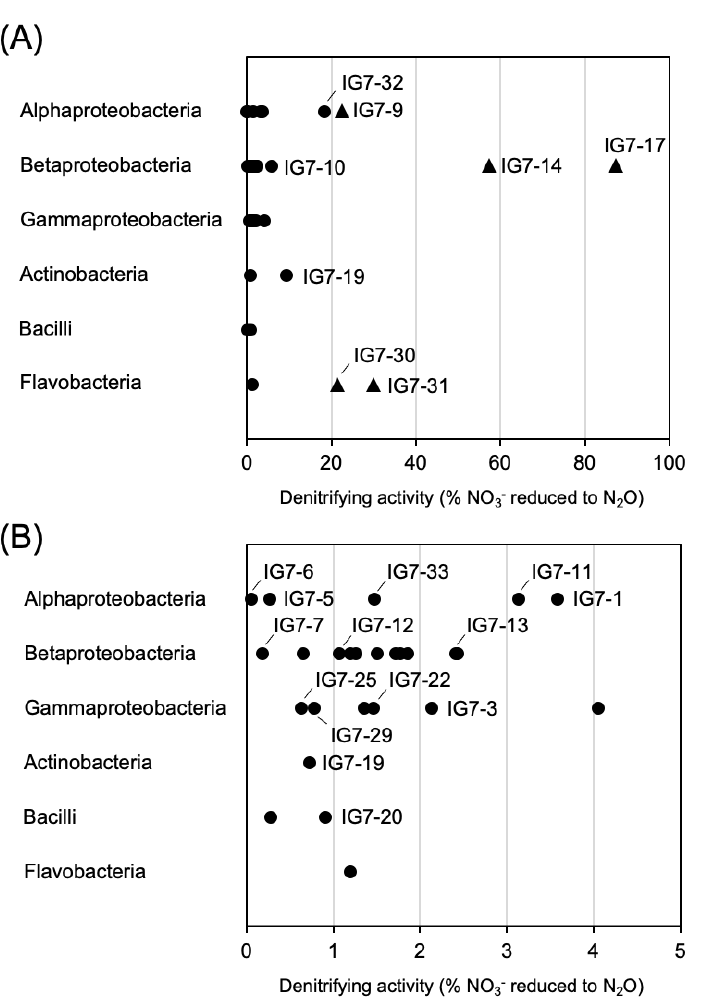
Figure 4. The denitrifying activity of OTUs. ( A ) shows strains that reduced more than 5% of the supplied NO 3 − to N 2 O. Black circles and triangles indicate strains that produced N 2 O from the supplied NO 3 − at levels of <20% and >20%, respectively. ( B ) shows strains that reduced less than 5% of the supplied NO 3 − to N 2 O. The x -axis and y -axis show the denitrifying activity (%) and the class of OTUs, respectively.